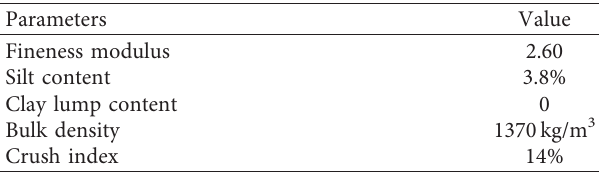
Figure 1: Physical appearance of crushed coal gangue: (a) coarse aggregate and (b) fine aggregate. Table 5: Main parameters of the fine aggregate.